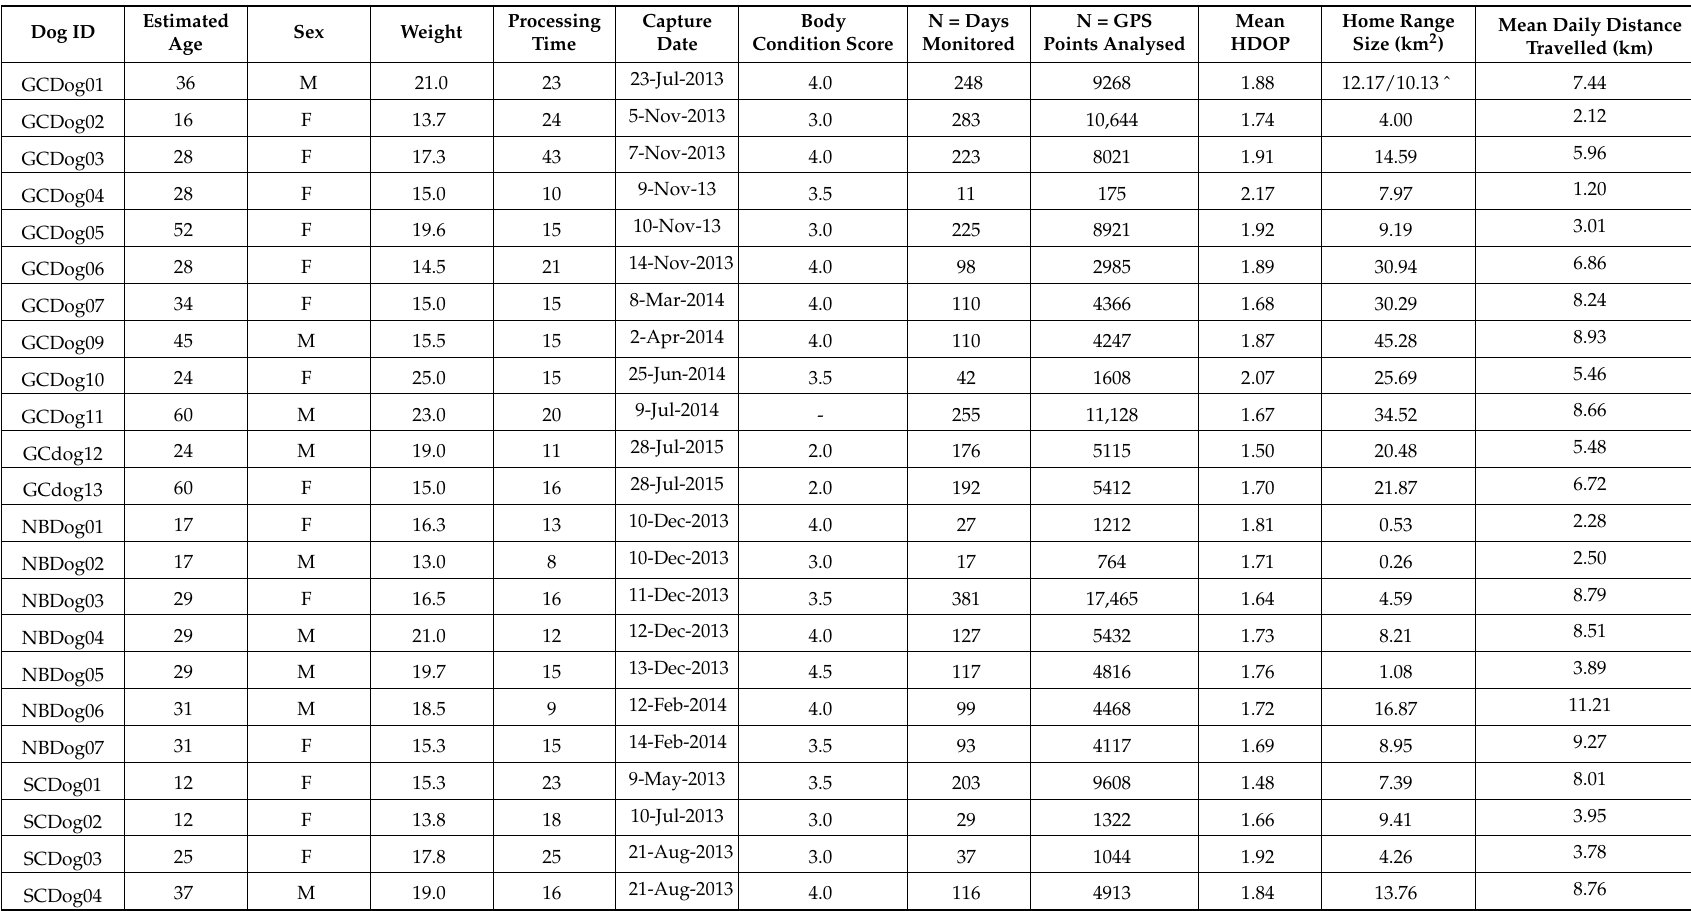
Table 2. Details of urban wild dogs trapped, collared and monitored in north-eastern Australia between May 2013 and March